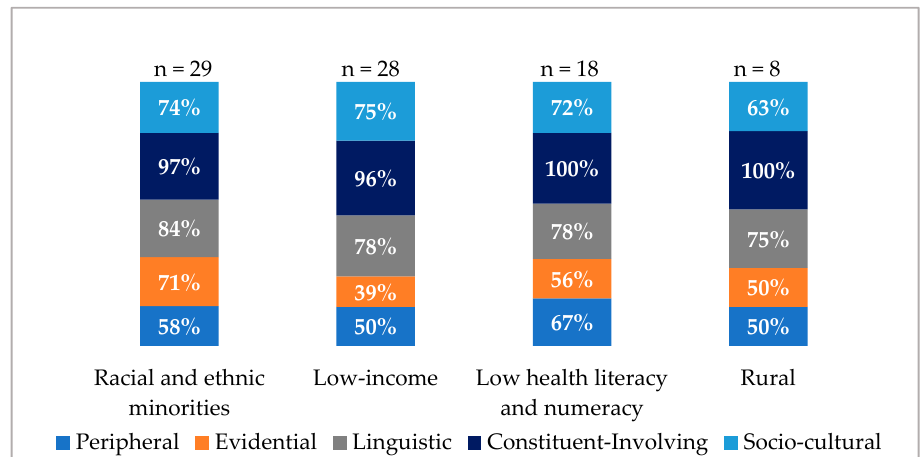
Figure 2. Cultural tailoring strategies by priority population.